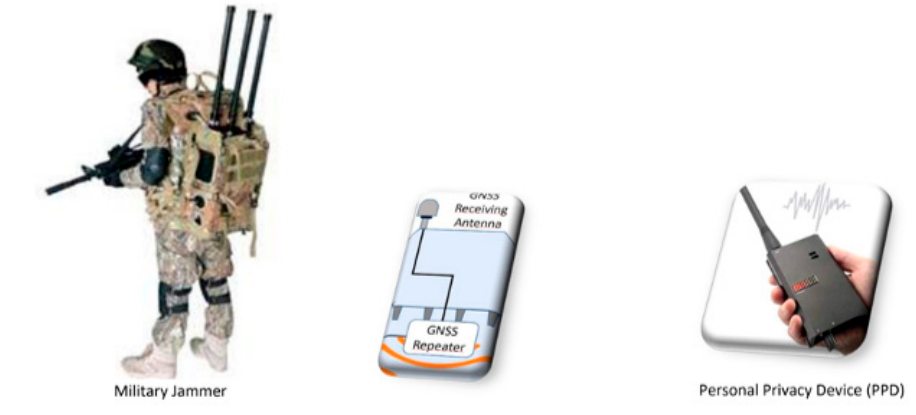
Figure 1. Main known sources of GNSS interference [2].